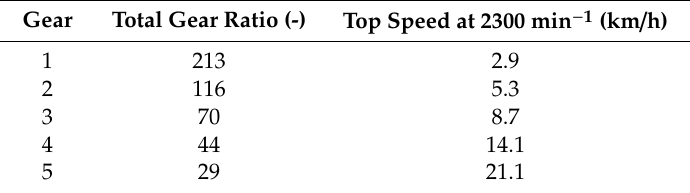
Table 1. Gear ratios and top speed [12].